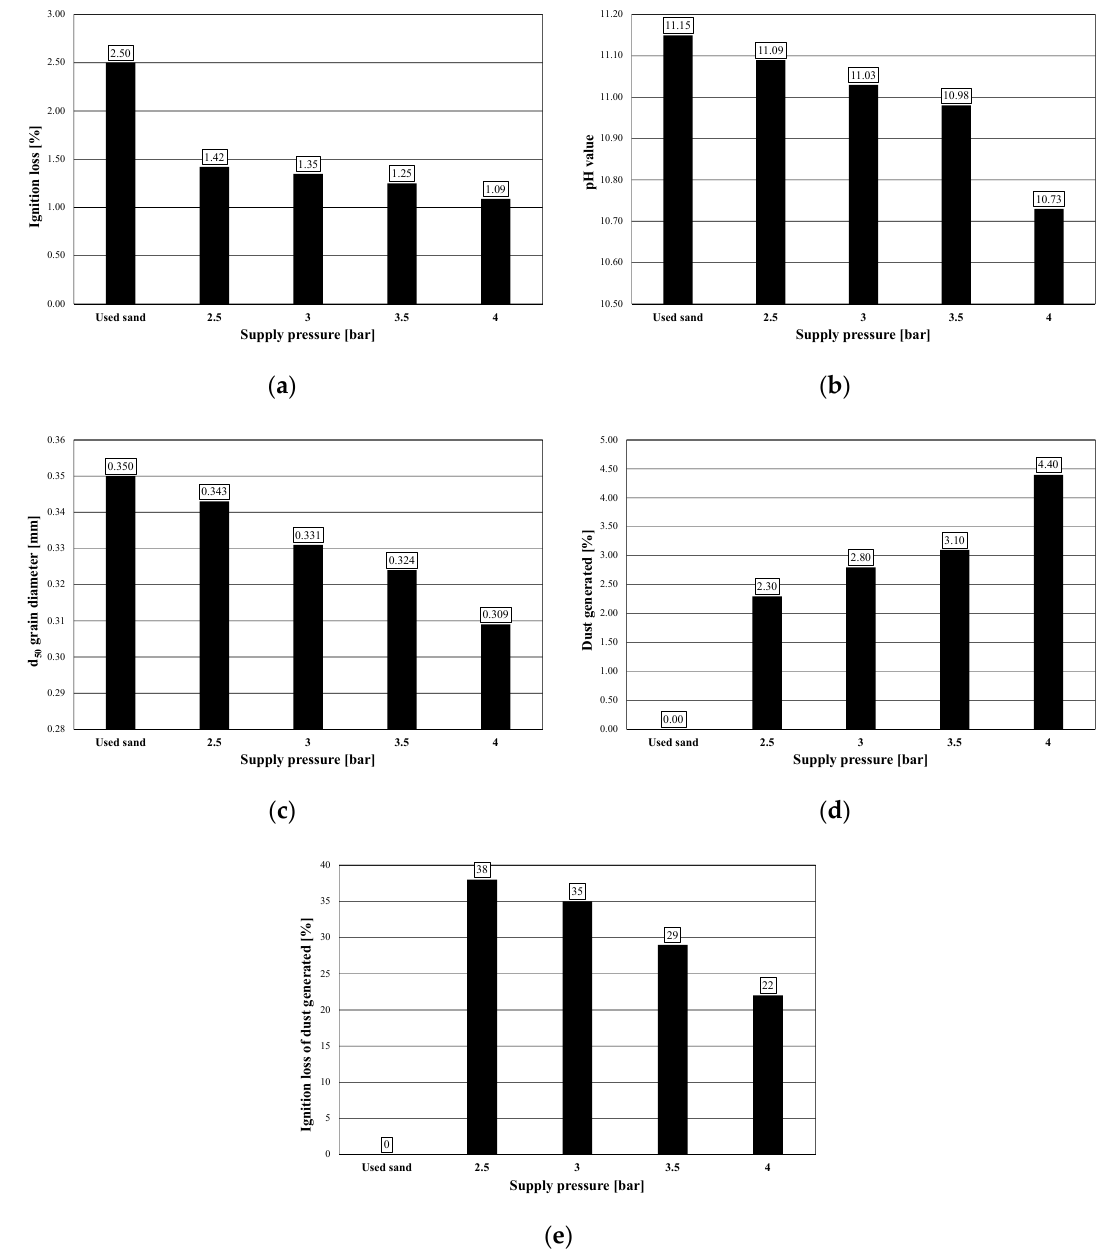
Figure 16. Results of verification tests: ( a ) ignition loss of obtained regenerates; ( b ) pH of the obtained regenerates; ( c ) regenerate grain size d 50 ; ( d ) amount of dust generated in the regeneration process; ( e ) ignition loss of dust.